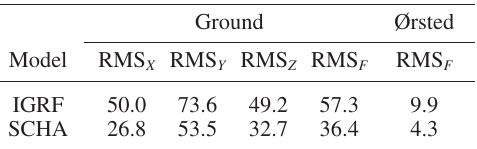
Table II. RMS fit to input data of SCHA and IGRF models (in nT).